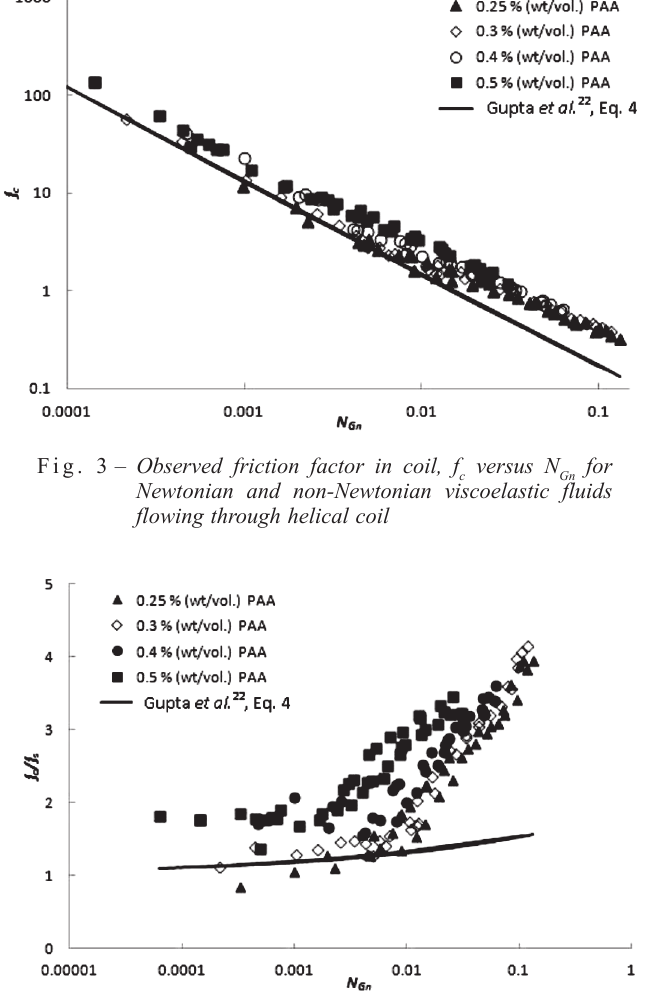
/f ) versus N for Newtonian c s Gn